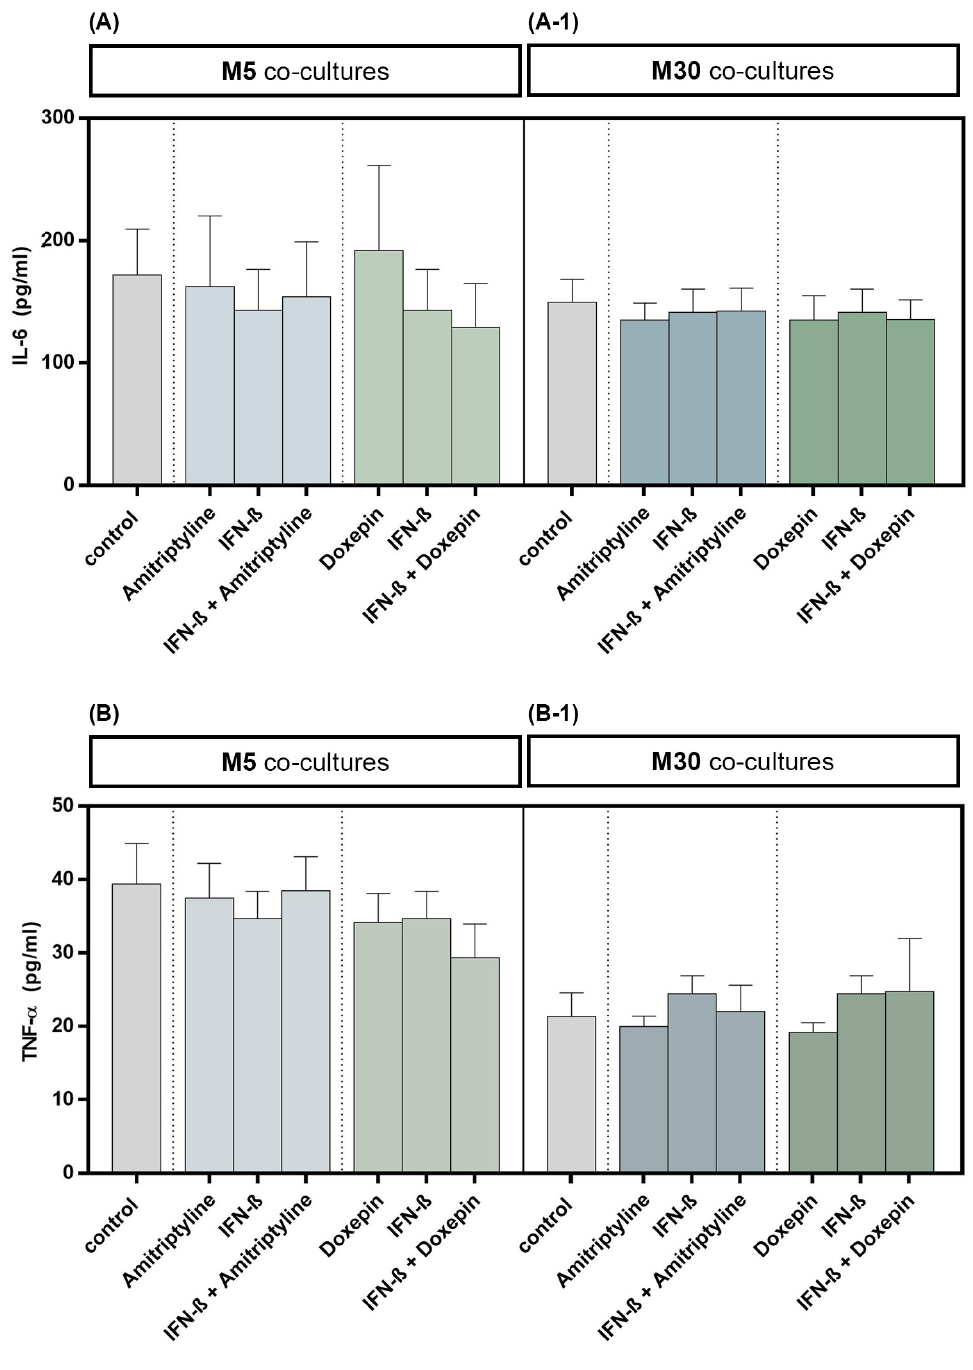
Figure 5. Interleukin-6 (IL-6) ( A , A-1 ) and tumor necrosis factor- α (TNF- α ) ( B , B-1 ) cytokine concen- trations quantified by ELISA in the supernatants of physiological (M5) ( A , B ) and pathological (M30) ( A-1 , B-1 ) co-cultures after incubation with 10 ng/mL amitriptyline or 10 ng/mL doxepin for 2 h, or with 2000 U/mL interferon- β (IFN- β ) for 22 h. Incubation with the drugs did not influence the IL-6 levels in M5 ( n = 9) as well as M30 ( n = 9) co-culture supernatants compared to controls. No significant change in TNF- α cytokine levels, in comparison to the controls, was measured in the supernatants of M5 and M30 co-cultures after incubation with the drugs ( n = 9). The Four Pa- rameter Logistic Regression protocol from myassays.com (https://www.myassays.com; accessed on 1 December 2021) was used in the analysis and statistics of the ELISA results. Untreated co- cultures were used as controls. The individual experimental conditions were compared by two tailed t-test. No significant differences between the individual conditions were detected ( p = ns).